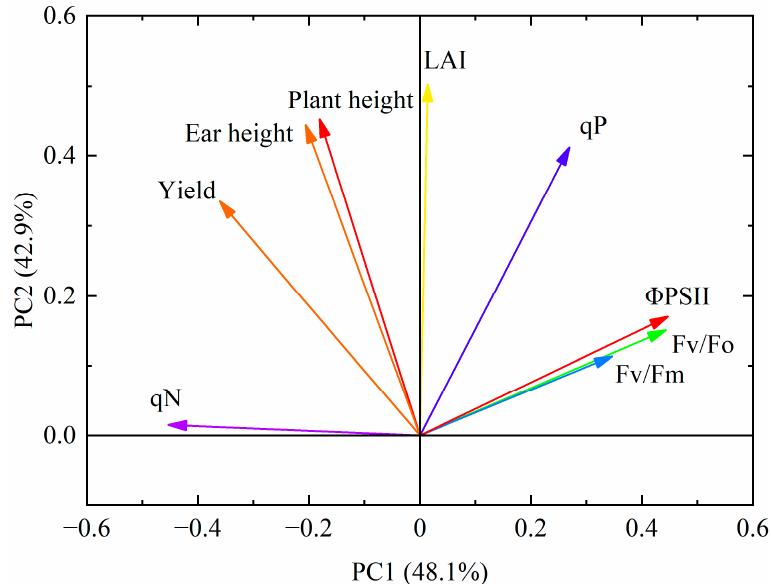
Figure 4. Principal component analysis of chlorophyll and yield. LAI is the leaf area index; Fv/Fo is the photochemical efficiency; Fv/Fm is the maximum photochemical efficiency; qP is the photo- chemical quenching coefficient; qN is the non-photochemical burst coefficient; Φ PSII is the actual photochemical efficiency.